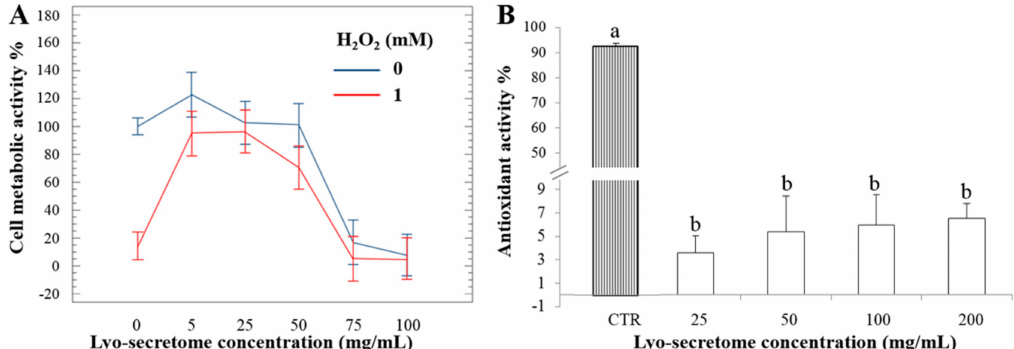
Figure 10. ( A ) Cell metabolic activity of NP cells treated with lyo-secretome with (red line) and without (blue line) H 2 O 2 . Mean values ± LSD ( n = 3), ANOVA. ( B ) Lyo-secretome antioxidant activity % measured in terms of radical scavenging by DPPH assay, mean values ± standard deviation ( n = 3). Different letters indicate statistical differences between the means ( p <